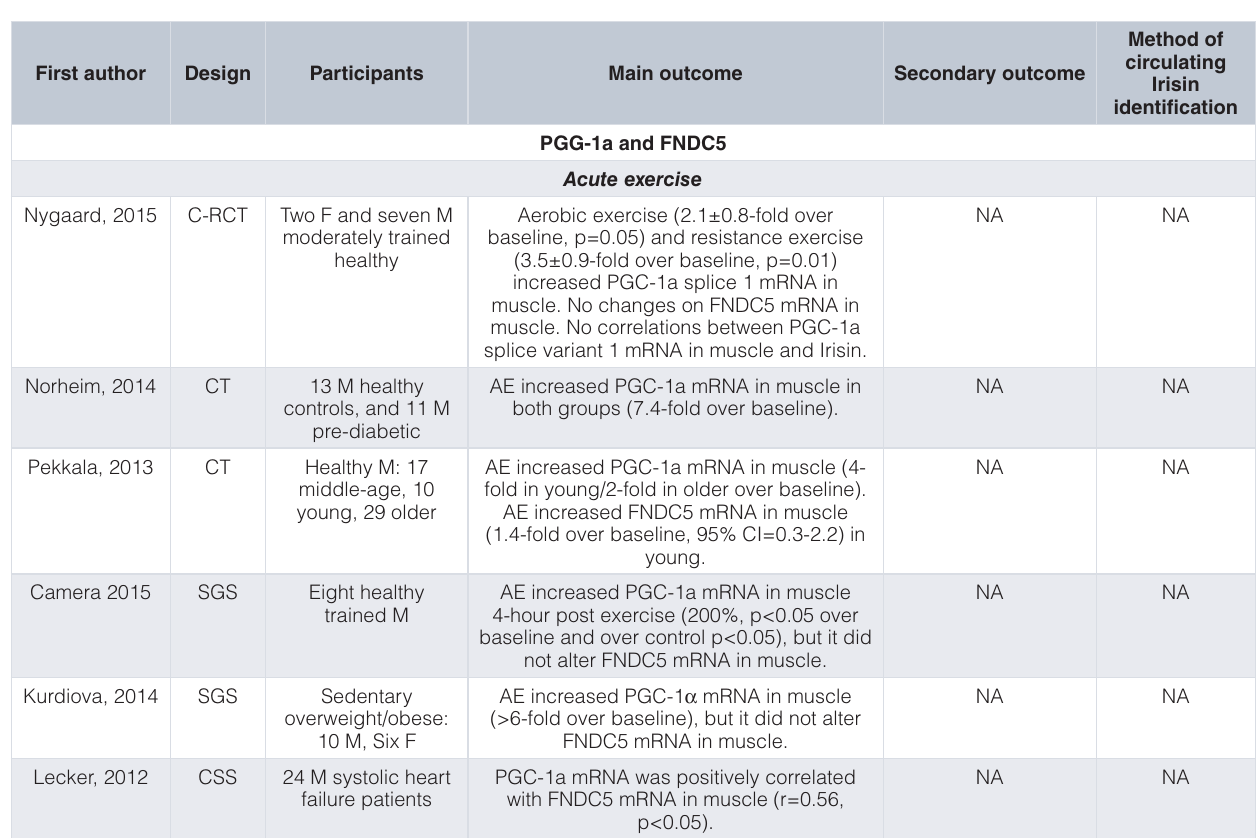
Table 1. Characteristics of the studies included in the systematic